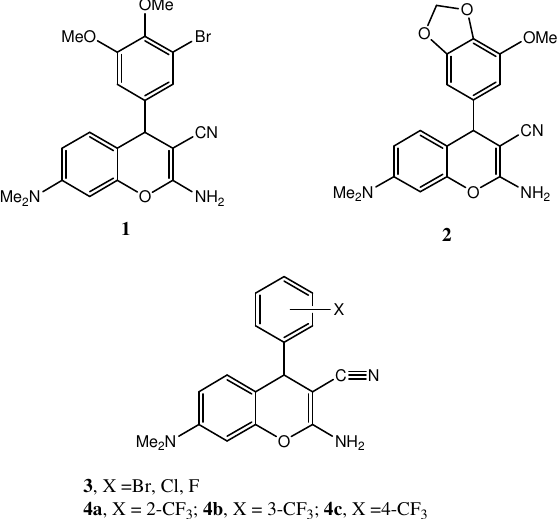
Figure 1. Chemical structures of compounds 1 -